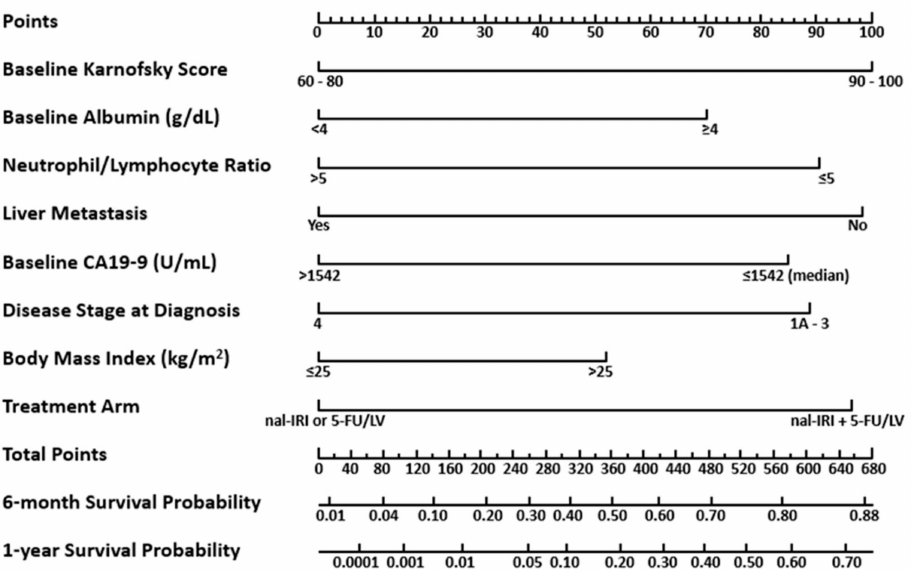
Figure 2. Nomogram to predict overall survival in patients with metastatic pancreatic cancer treated with nal-IRI + 5-FU / LV in the NAPOLI-1 study. 5-FU / LV, 5-fluorouracil / leucovorin; CA19-9, cancer antigen 19-9; nal-IRI, liposomal